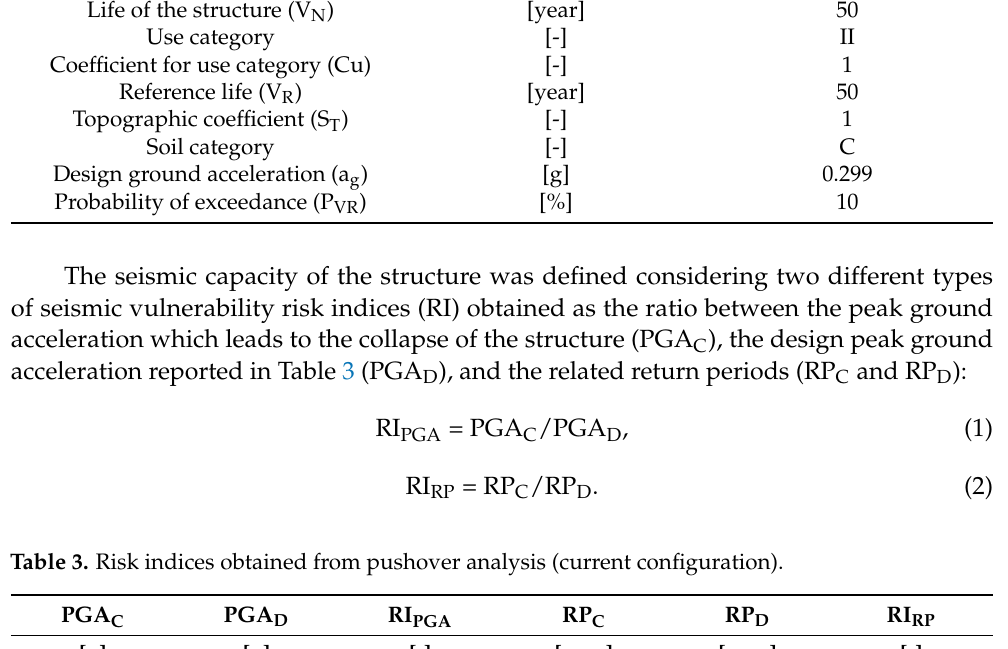
Table 3. Risk indices obtained from pushover analysis (current configuration).